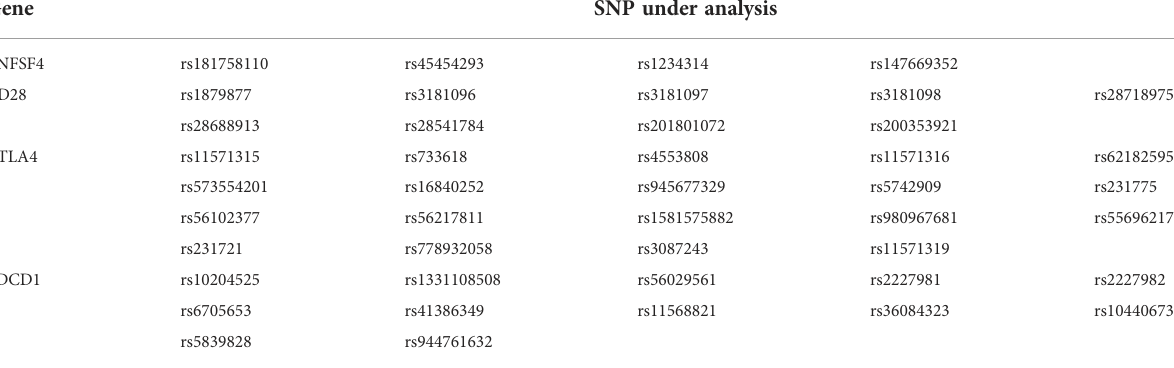
TABLE 2 The 44 candidate SNPs that were analyzed the association with vaccine-induced reaction.